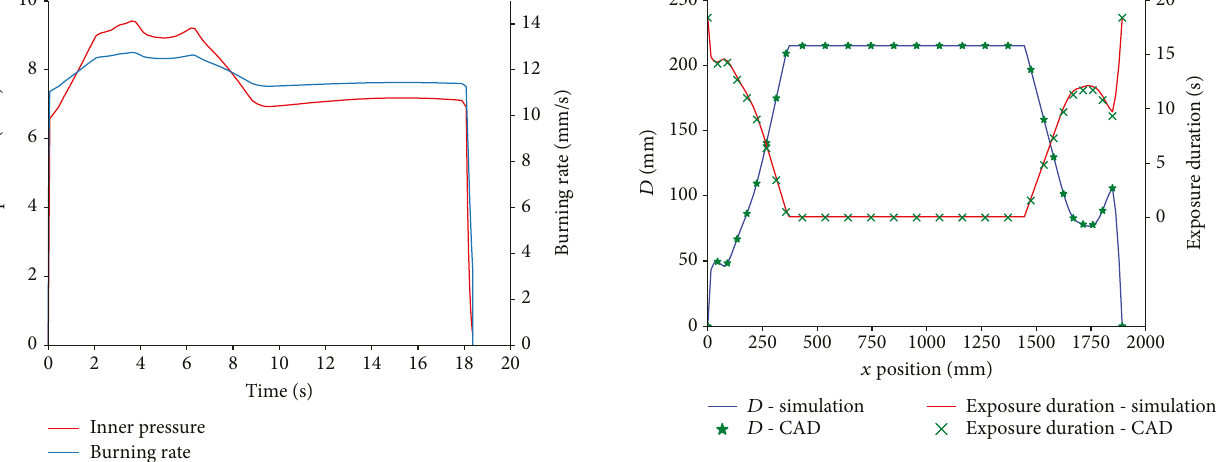
Figure 6: Inner ballistic and transient burning rate of the sample SRM.